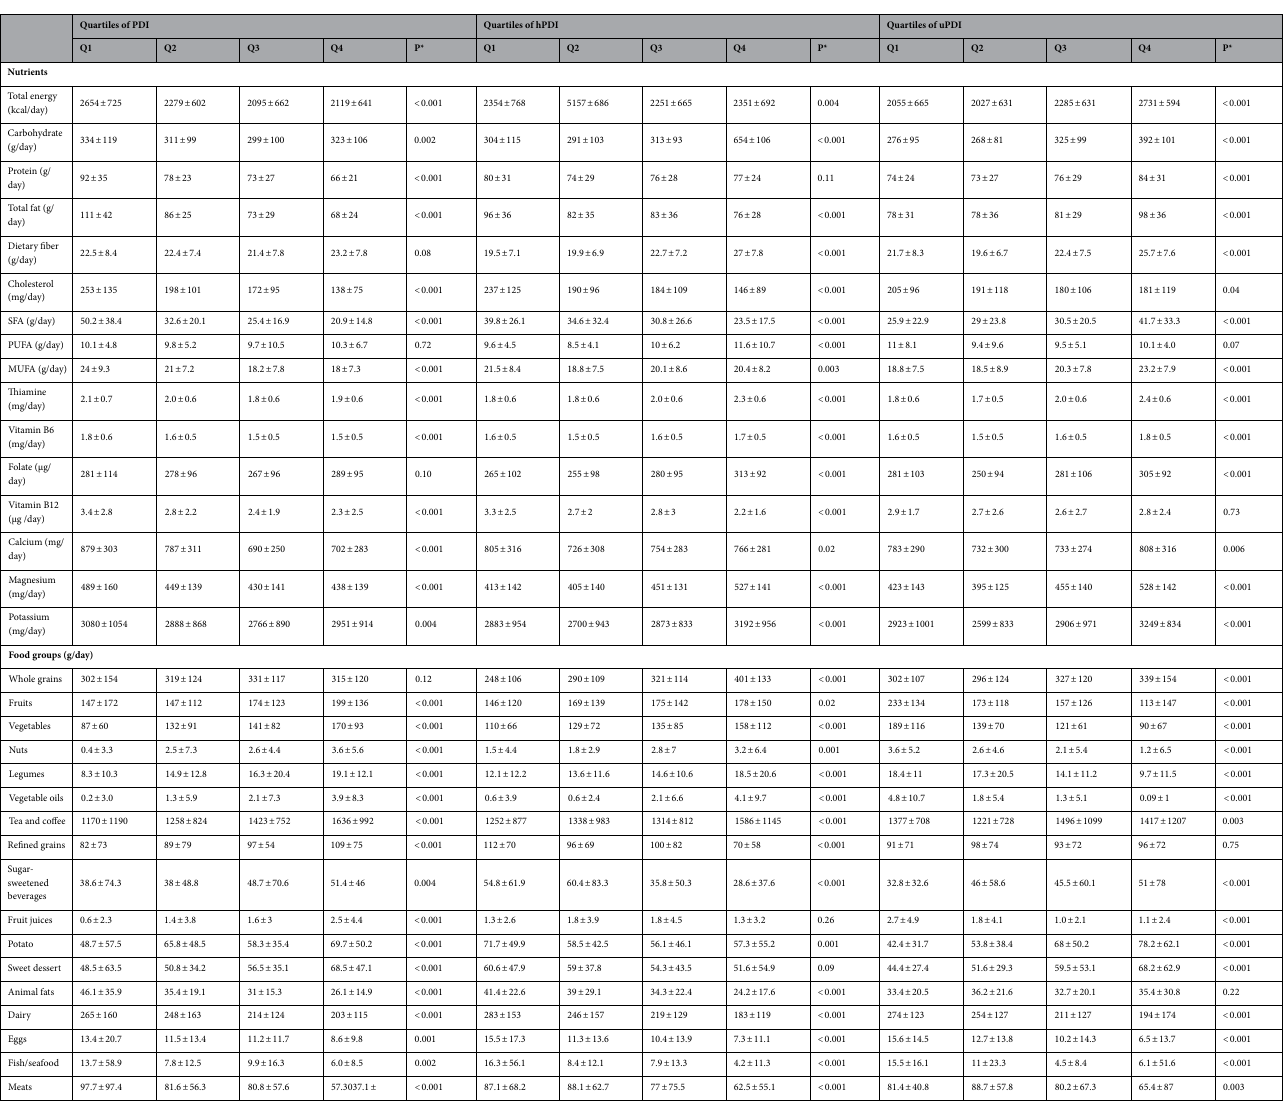
Table 3. Dietary intakes of study participants across quartiles of PDI, hPDI, and uPDI scores. All values are mean ± SD. BMI body mass index, MET metabolic equivalents, SES social economic status, PDI overall plant- based diet index, hPDI healthy plant-based diet index, uPDI unhealthy plant-based diet index. *Obtained from ANOVA.